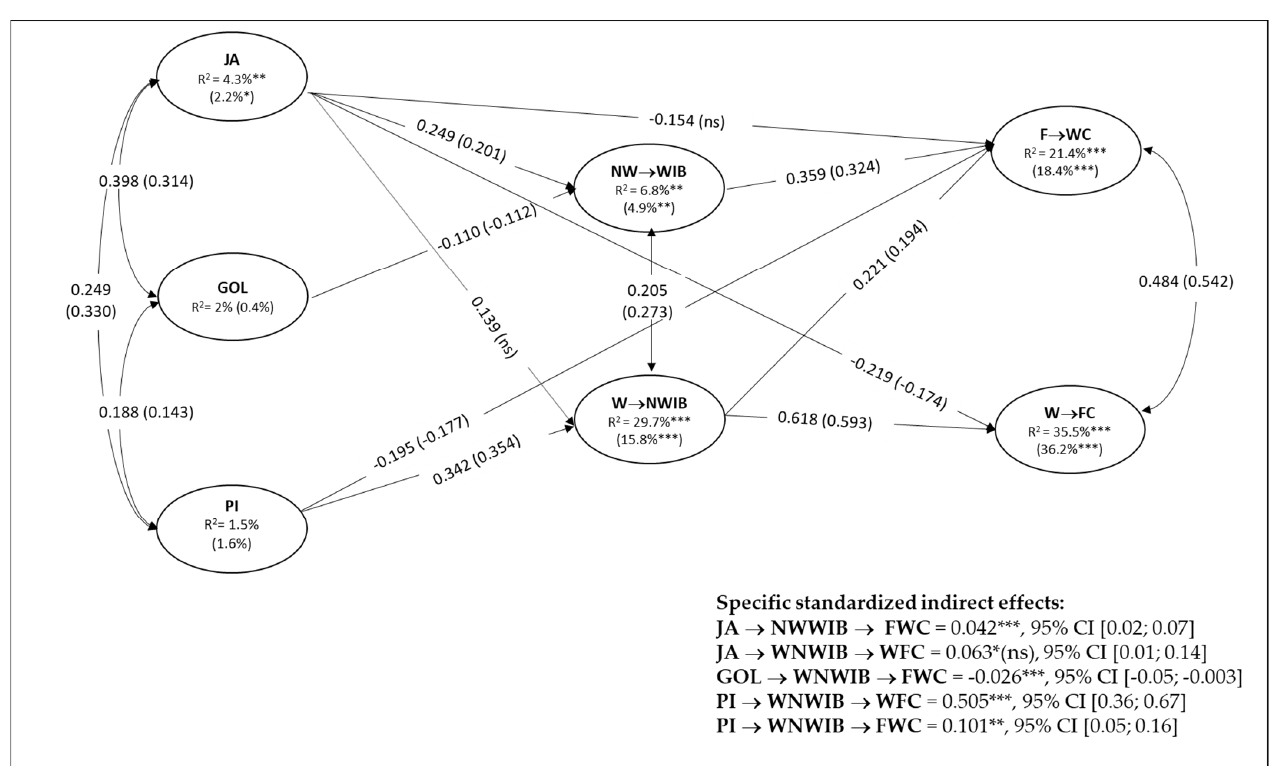
Figure 2. Results from multigroup structural equation analysis and study variables’ explained variance by the model. Notes. * p < 0.05; ** p < 0.01; *** p < 0.001. Figure reports significant standardized regression coefficients between study variables, controlled for gender, age, education level and professional qualification; results for remote workers are reported in parentheses; JA = job autonomy; GOL = goal-oriented leadership; PI = personal initiative at work; NW → WIB = non- work interrupting work behaviors; W → NWIB = work interrupting work behaviors; W → FC = work-to-family conflict; F → WC = family-to-work conflict R 2 = r-square